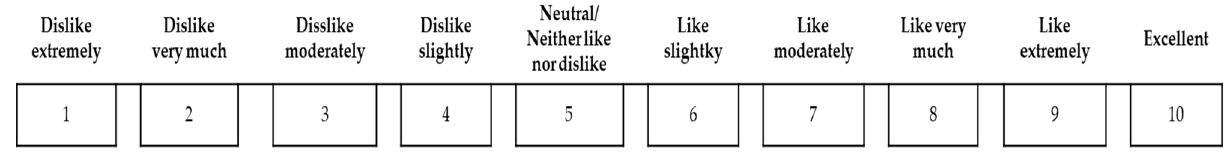
Figure 4. Hedonic 10-point scale.